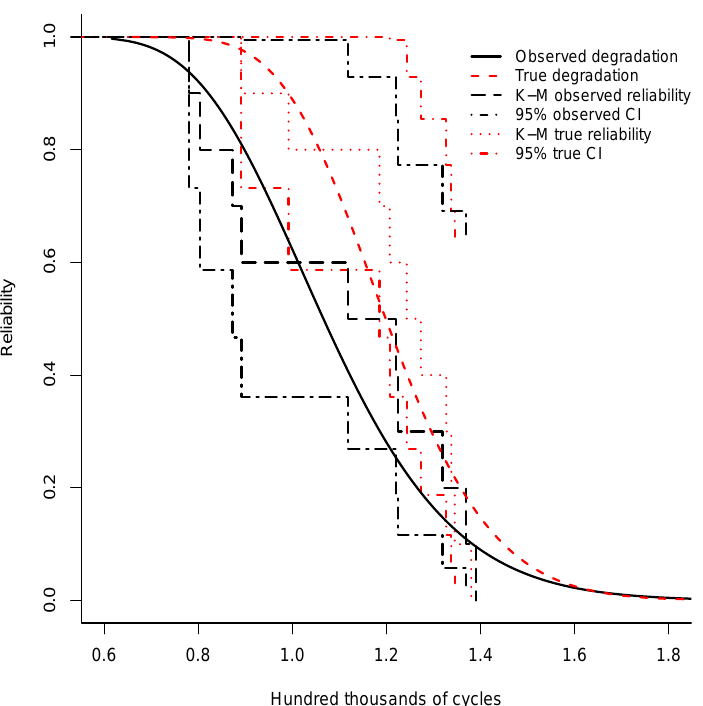
Figure 8. The effect of the measurement error illustrated by the comparison of the estimated reliability functions and the Kaplan–Meier estimation with confidence